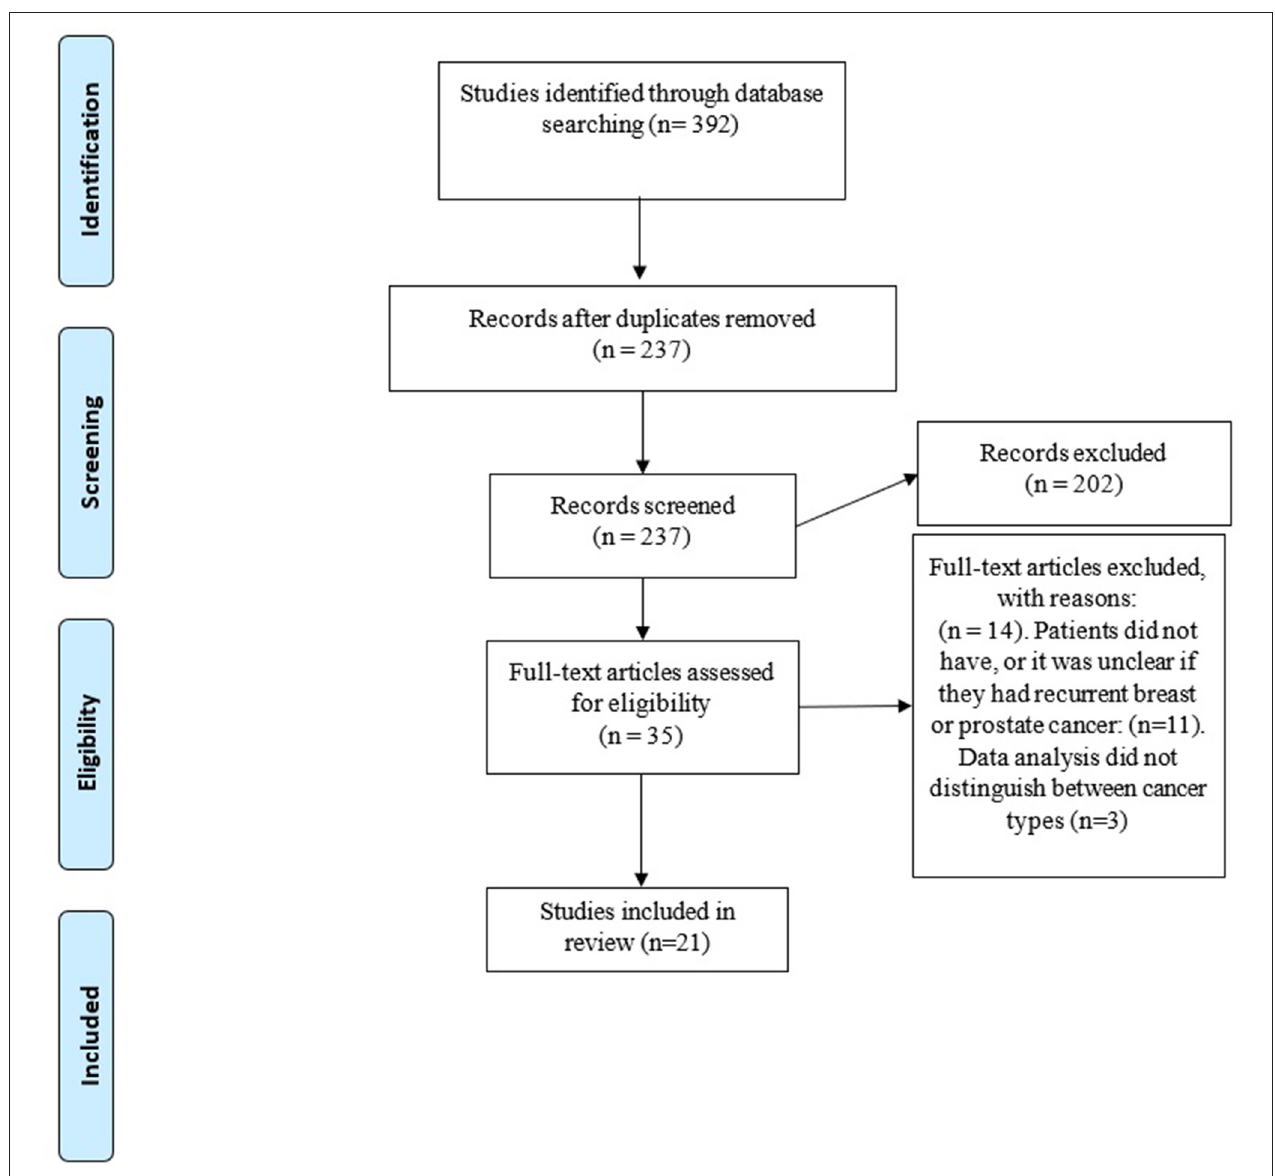
FIGURE 1 | Flow diagram of database searching and study